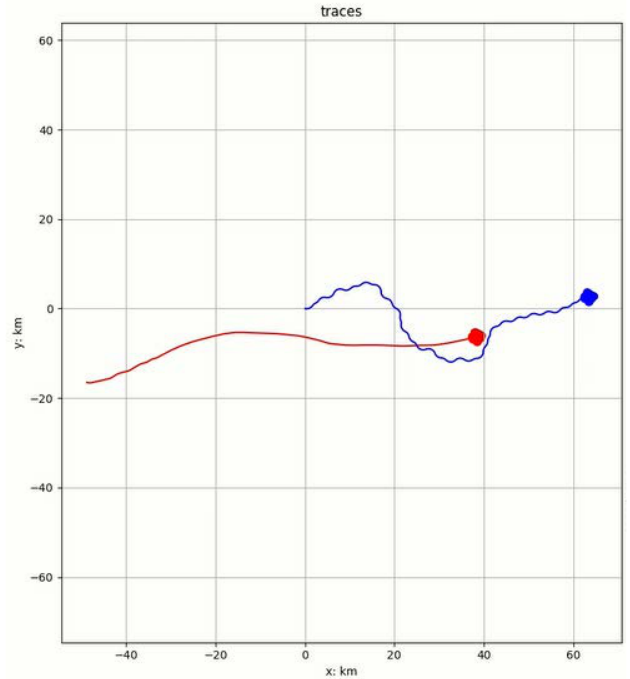
Figure 9. 2D advantage: air confrontation process.